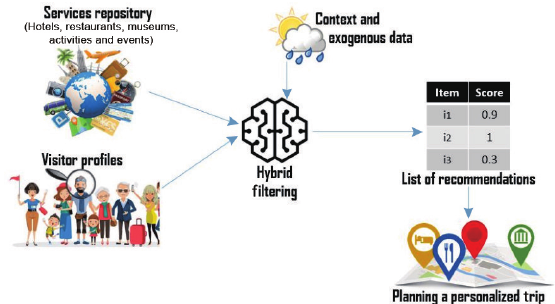
Fig. 1 Proposed architecture for tourism recommender